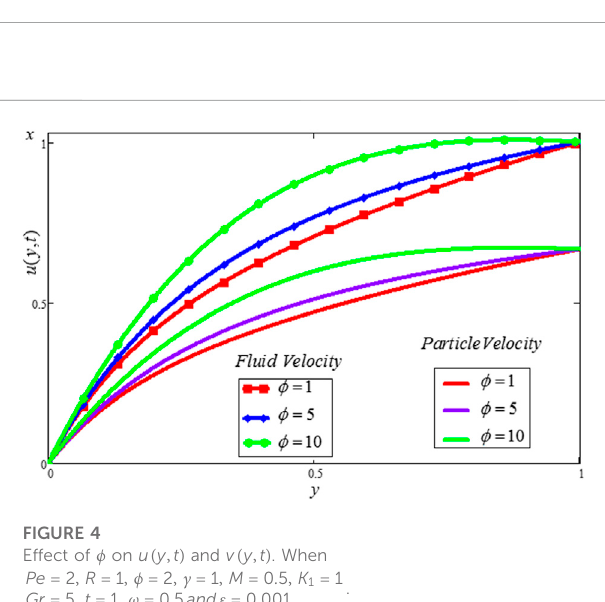
FIGURE 3 Effect of β on u ( y , t ) and v ( y , t ) . When Pe (cid:2) 2 , R (cid:2) 1 , ϕ (cid:2) 2 , γ (cid:2) 1 , M (cid:2) 0 . 5 , K Gr (cid:2) 5 , t (cid:2) 1 , ω (cid:2) 0 . 5 and ε (cid:2) 0 . 001 .